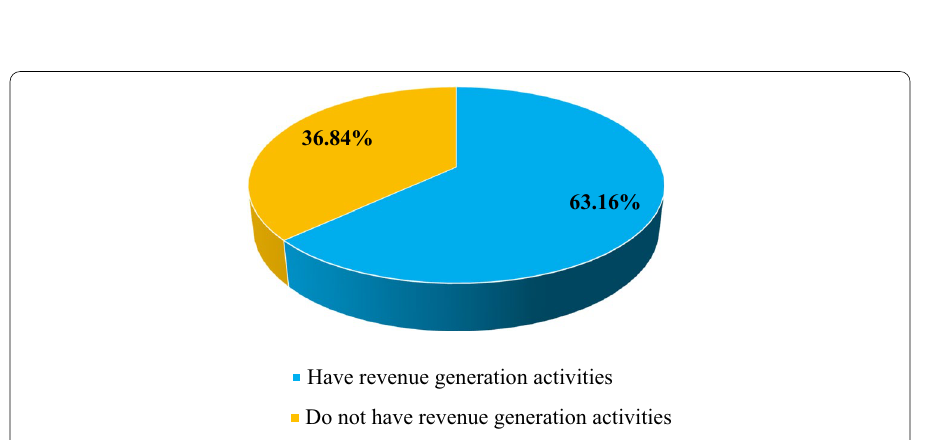
Fig. 24 Revenue generation